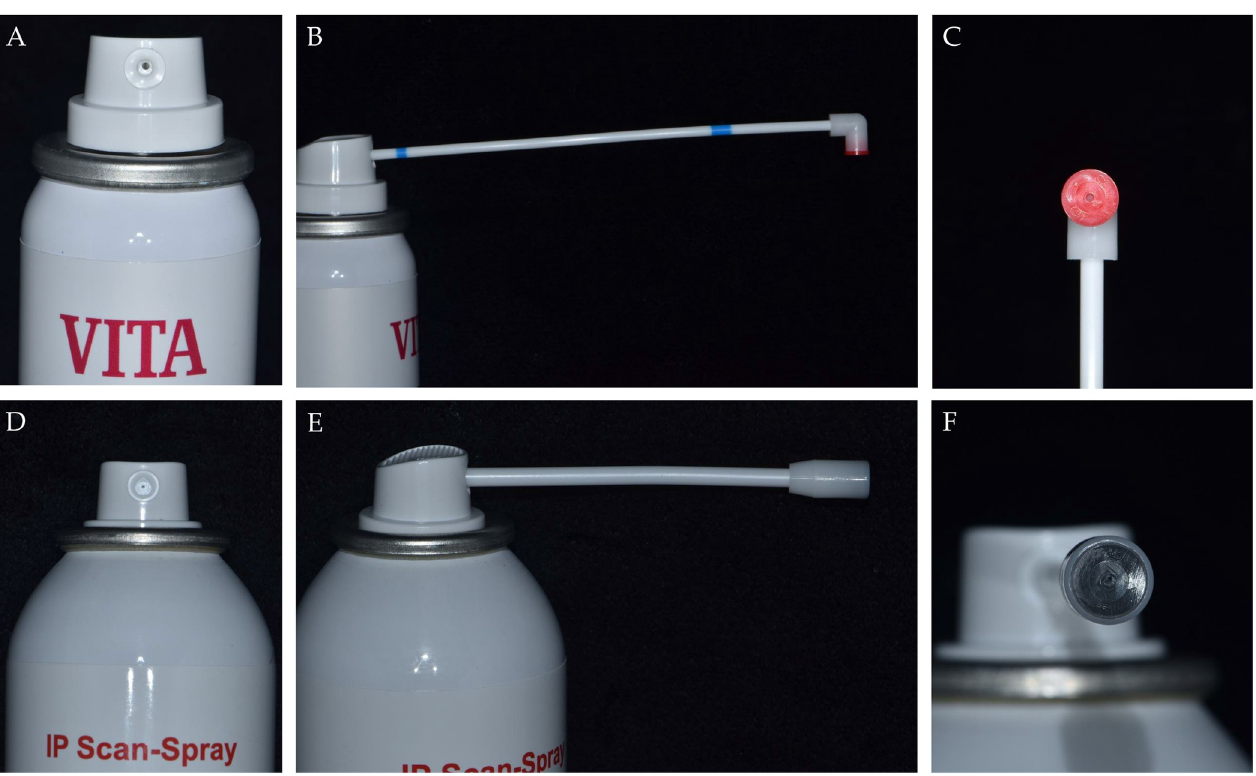
Fig 4. Box plots of the RMS values for three experimental groups (Scancure, IP, VITA) in three reference models. A–inlay; B–onlay; C—bridge.